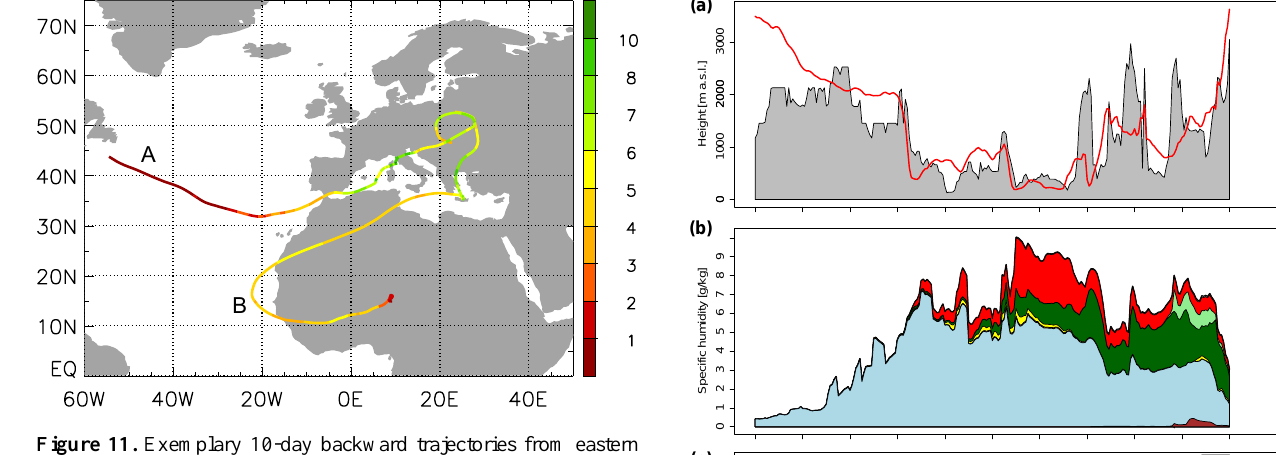
Figure 11. Exemplary 10-day backward trajectories from eastern Europe started at 12:00UTC on 16 May 2010 with a trajectory path ending over the Atlantic (A) and over Africa (B) . Colours indicate the specific humidity along the trajectories in gkg − 1 . Trajectory A starts from 22.75 ◦ E, 46.54 ◦ N and a height of 3626m. Trajectory B starts from 23.39 ◦ E, 52.75 ◦ N and the same height.